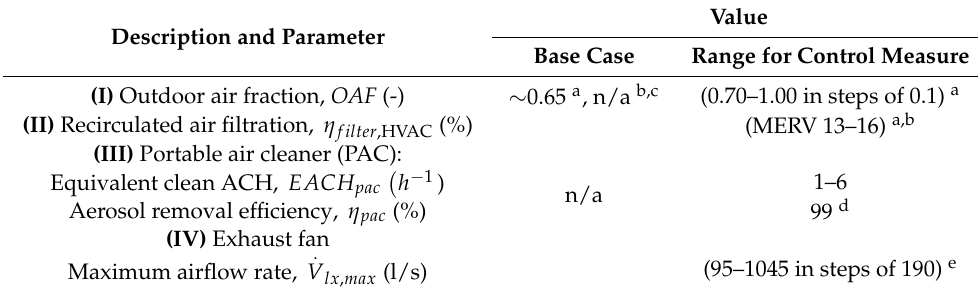
Table 2. Input modeling parameters to simulate the reduction of virus-laden bioaerosols exposure in a highly occupied indoor space (bar or pub) by using HVAC and non-HVAC control measures. Value Description and Parameter Base